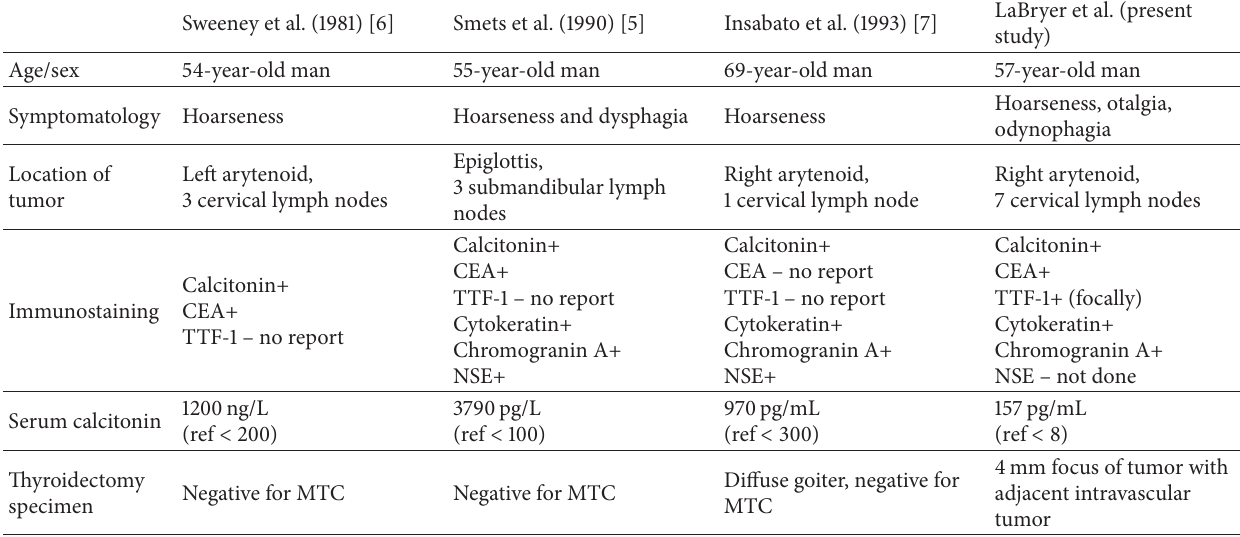
Table 1: Comparison of reported MDNC of larynx with hypercalcitoninemia.